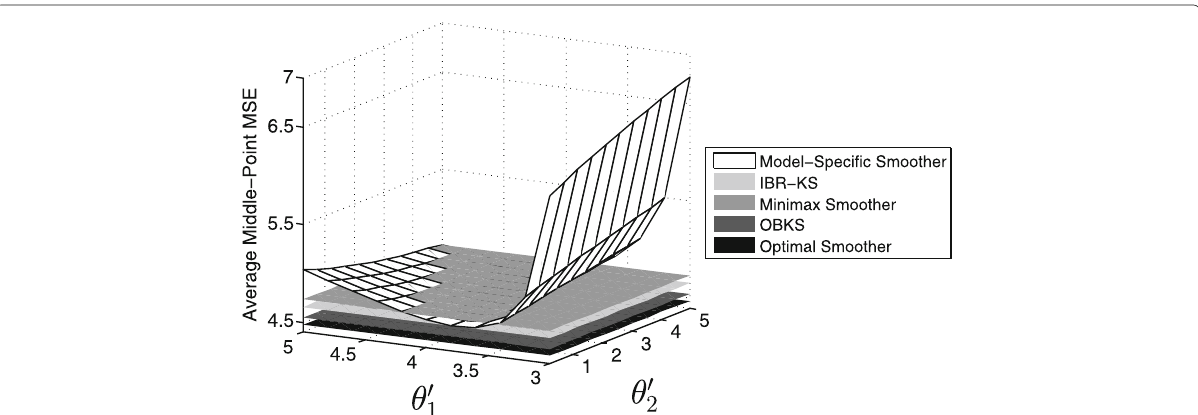
Fig. 6 Average middle-point MSE of different Kalman smoothers for the target tracking example with unknown r and q . The average performance of each model-specific Kalman smoother corresponding to the noise parameters θ (cid:7) 1 and θ (cid:7) 2 is shown. The average MSE for the IBR-KS, minimax, OBKS, and the average of optimal MSEs are shown as constant planes